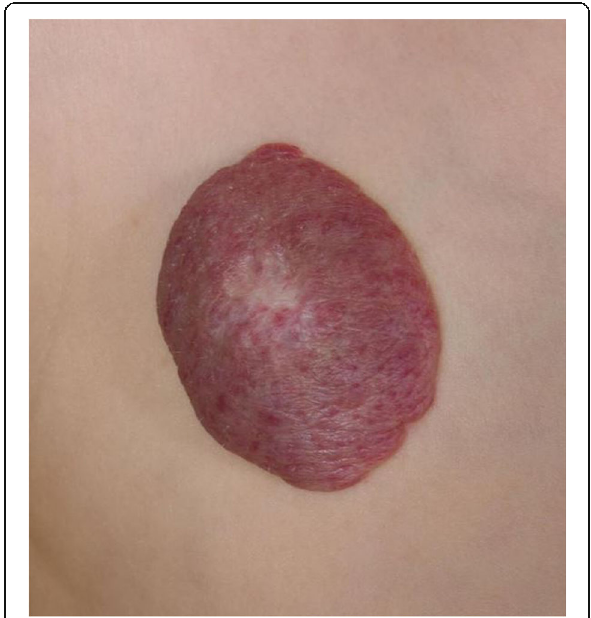
Fig. 1 Typical appearance of a superficial infantile haemangioma